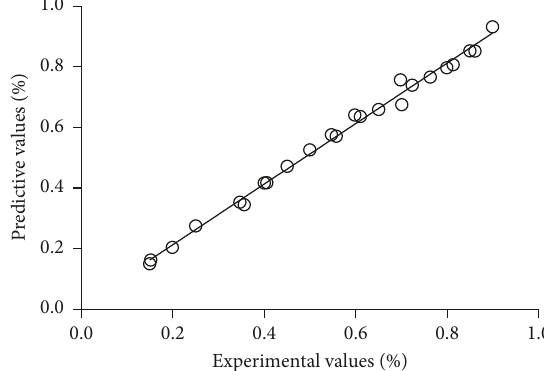
Figure 5: Fitting trend diagram of Tween 80 verification set.